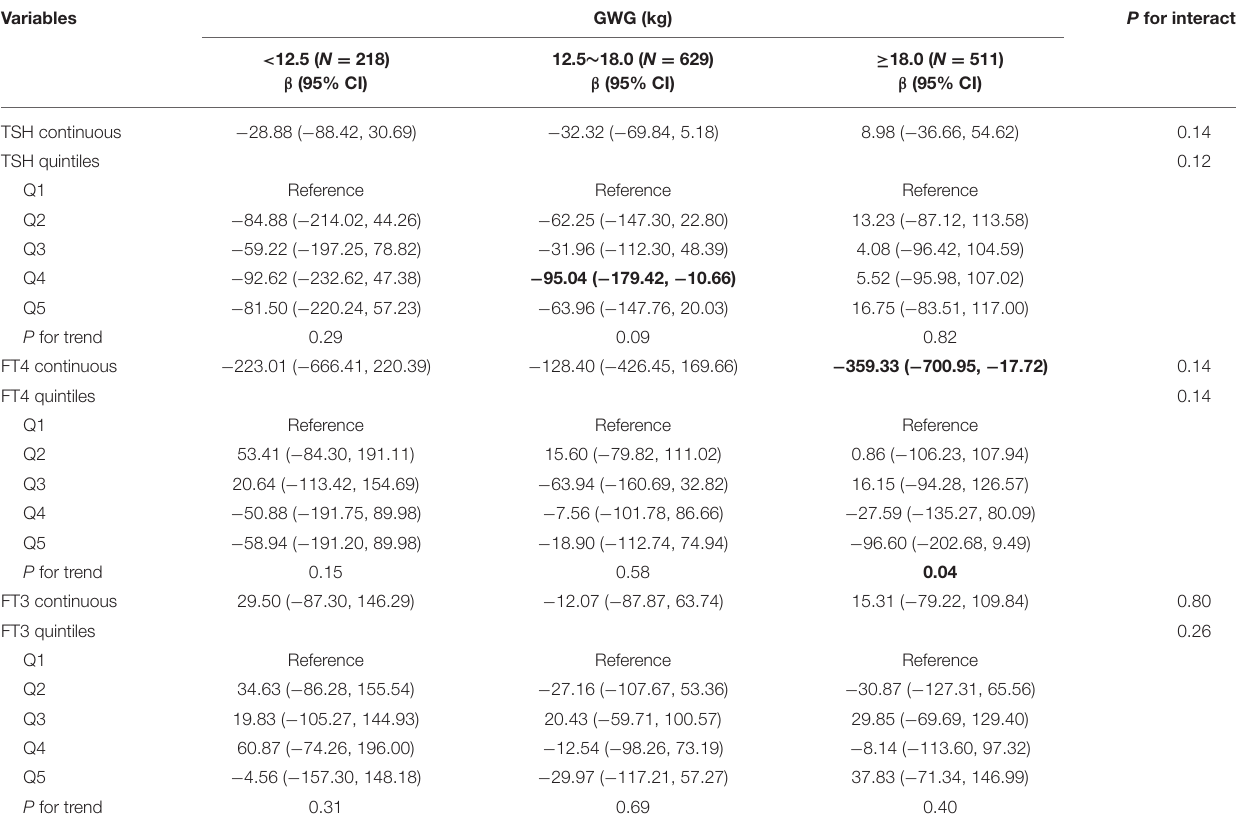
TABLE 5 | Adjusted regression coefficients a for birth weight associated with maternal thyroid parameters during early pregnancy stratified by GWG among underweight women ( N = 1,358).